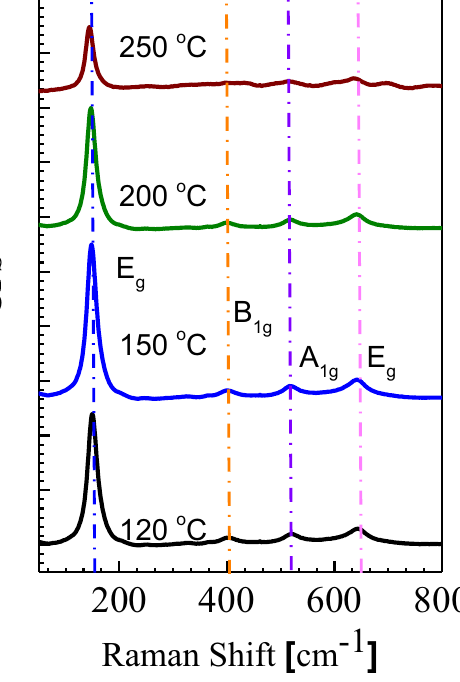
Fig. 1 Raman spectra of mesoporous titanium oxide